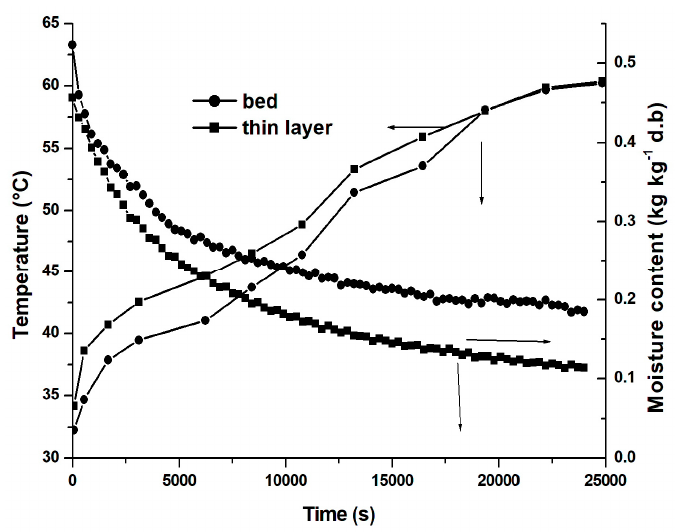
Figure 9. Comparison between the evolution of moisture content and the temperature of the thin layer and the packed bed as a function of time; T = 60 °C, V = 1 m·s − 1 (dry air RH = 0%).